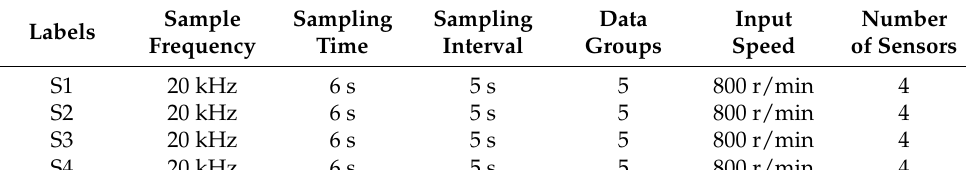
Table 2. Experimental data acquisition scheme.